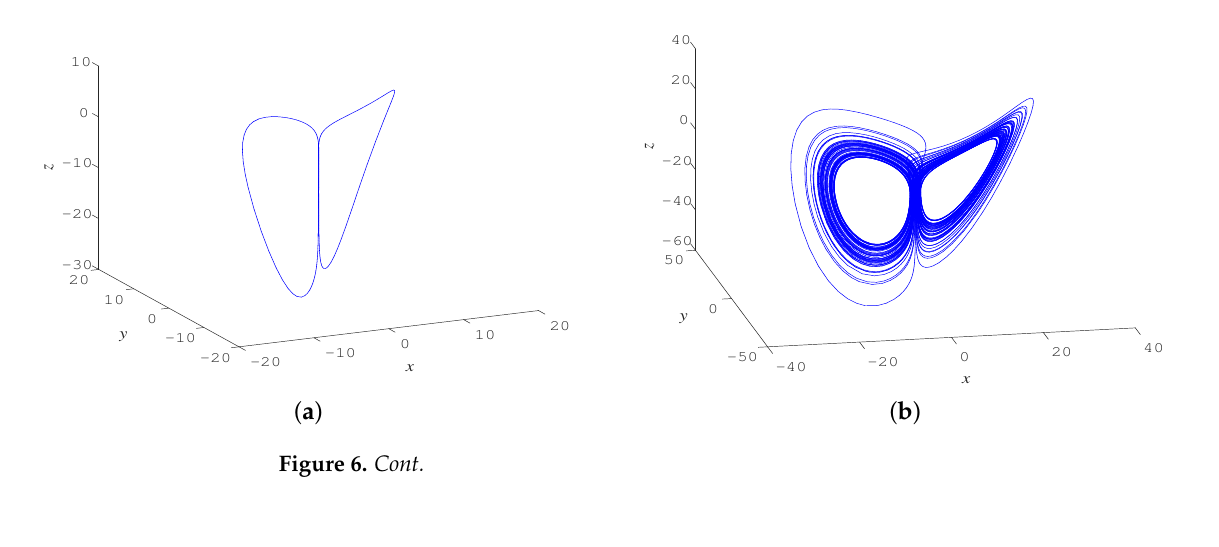
Figure 5. Largest Lyapunov exponent spectrum ( a ) and bifurcation diagram ( b ) of system (1) versus b , where a = 10, c = 11.2, k = − 0.2.